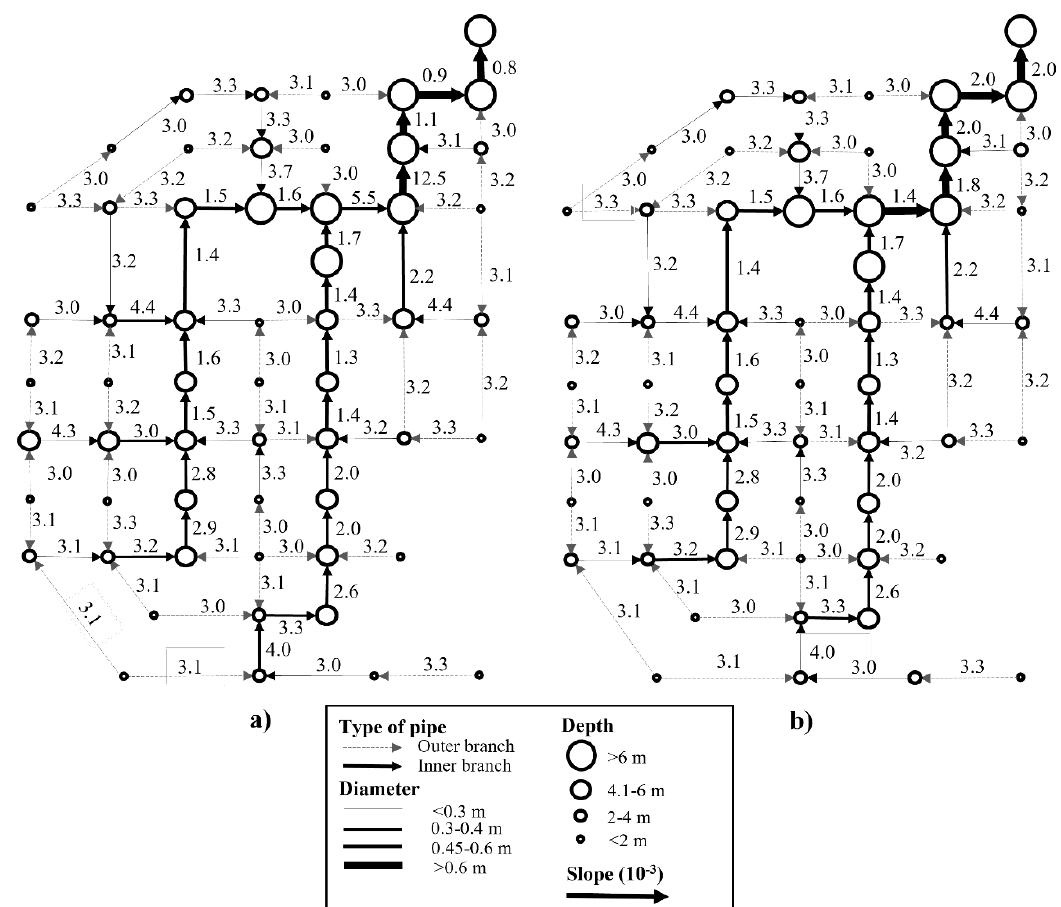
Figure 6. Scheme (not to scale) of the best design of the benchmark network proposed by Li and Matthew [34] with ( a ) their cost function and ( b ) the cost function of Maurer et al. [47].